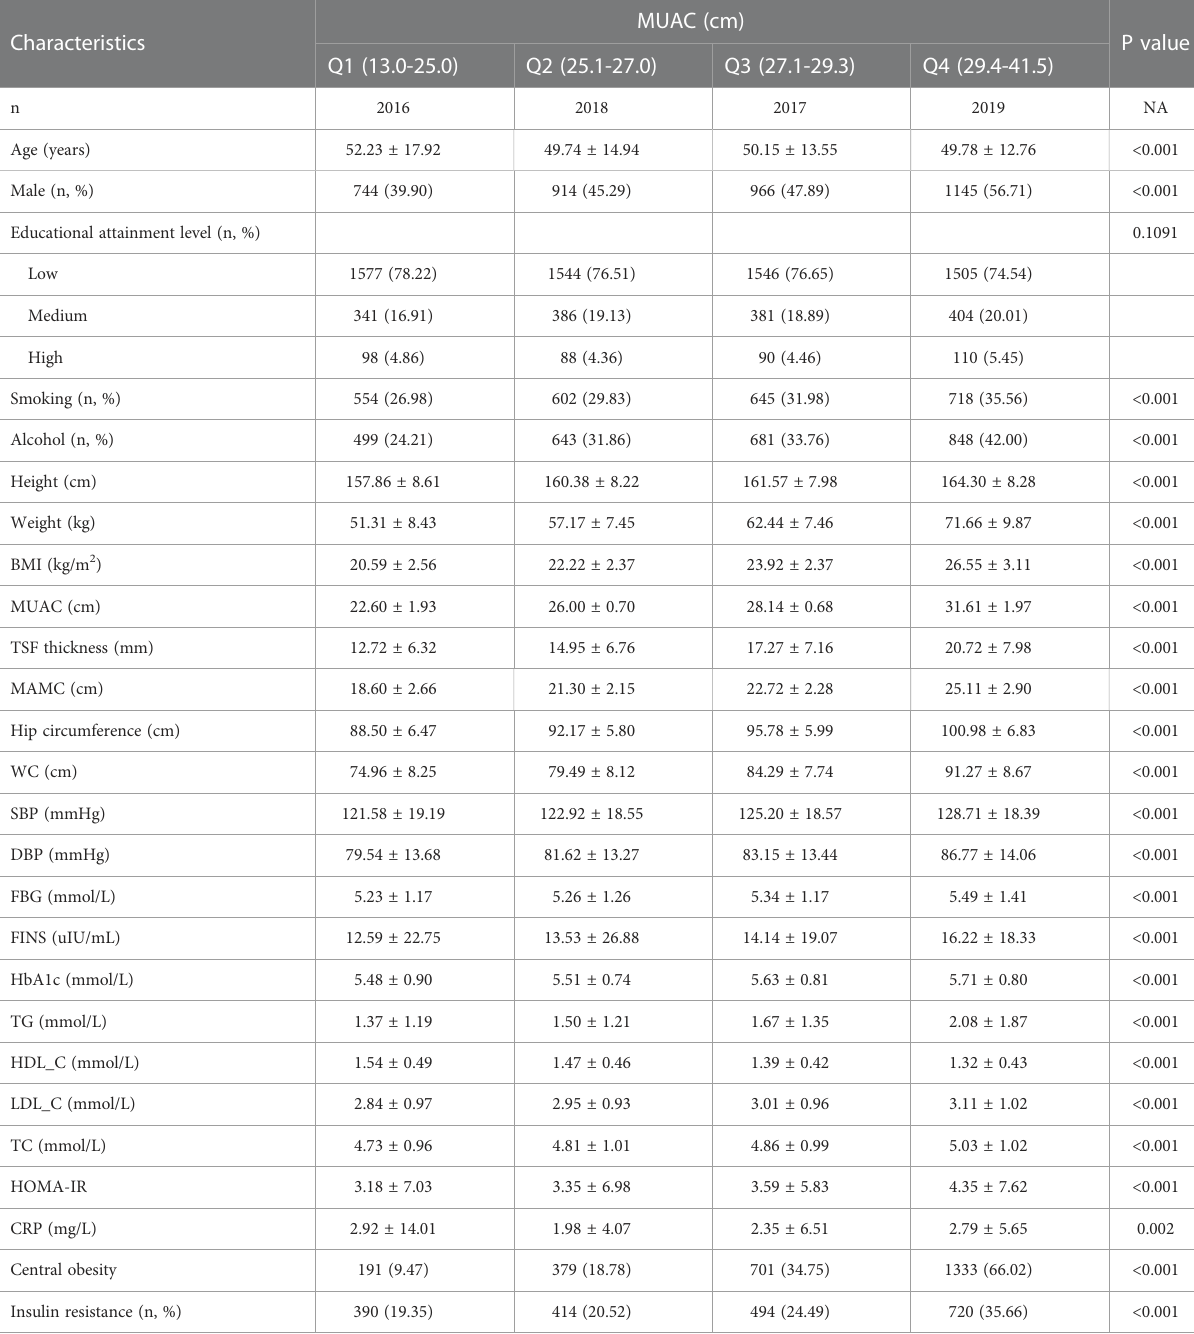
TABLE 1 Baseline characteristics of the study population according to mid-upper arm circumference quartiles.